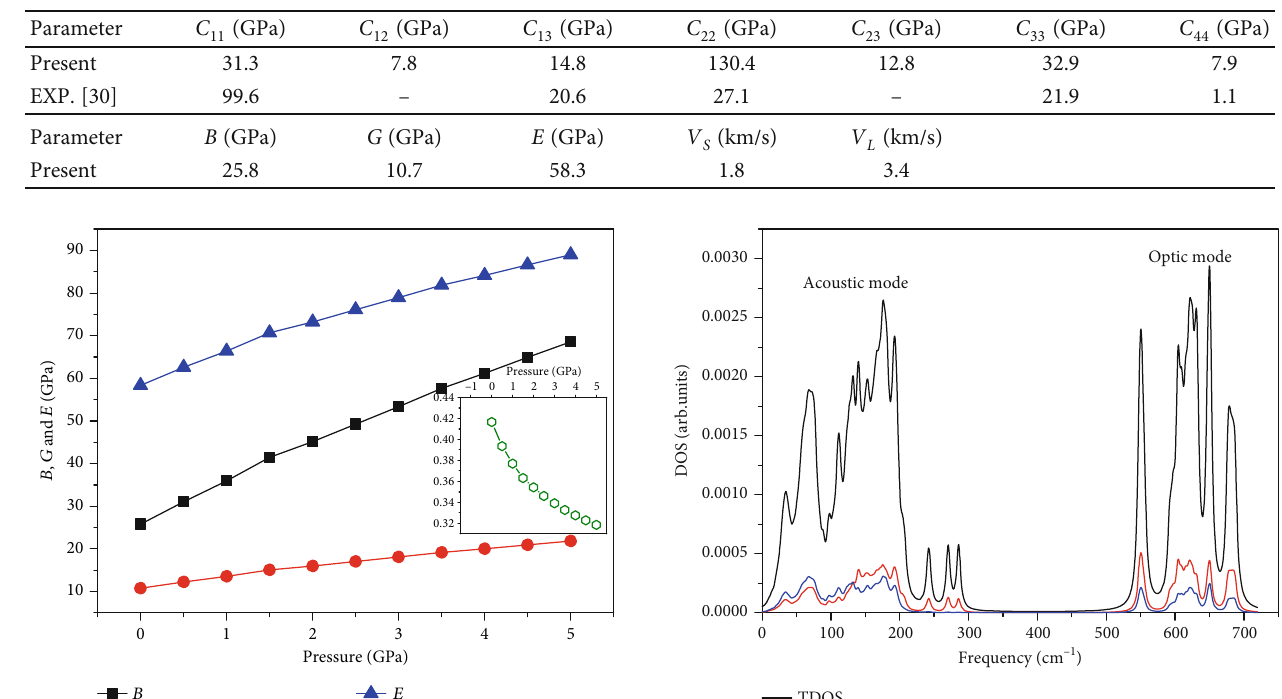
Table 1: The present calculated results and experimental results of the elastic and mechanical parameters of As